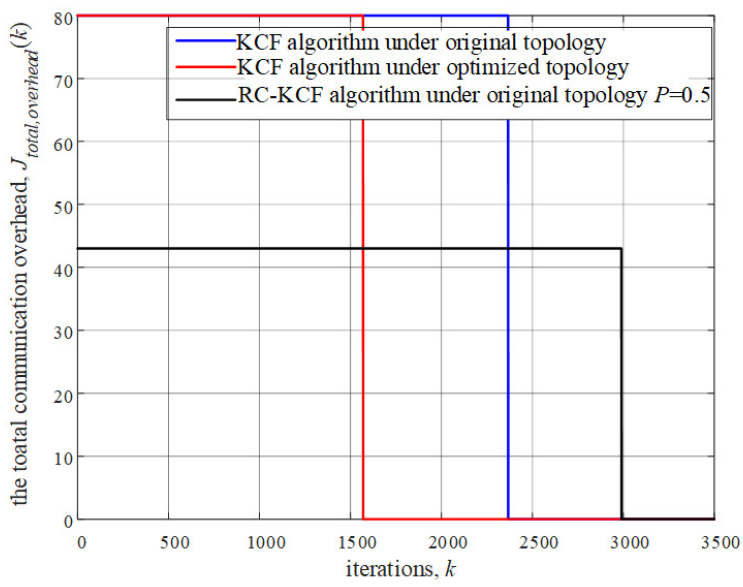
Figure 5. The total communication